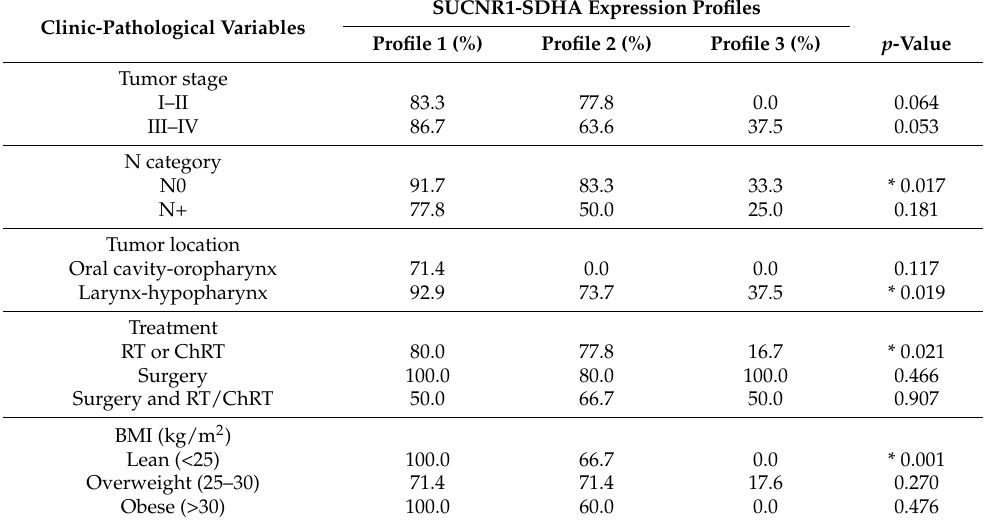
Table 4. In the univariate study, the analysis showed that the profile was significantly related to the locoregional disease-free survival. Considering patients with profile 1 as the reference category, those with higher profiles had a higher risk of local and regional failure of the tumor after treatment. Specifically, those patients included in profile 2 had a 2.5-fold higher risk of recurrence (CI 95%: 0.5–12.2, p = 0.272), and patients with profile 3 had a 6.6-fold higher risk (CI 95%: 1.4–32.1, p = 0.019). Table 3. Local and Regional Recurrence Free-Survival According to Clinical Variables and to SUCNR1 and Succinate Dehydrogenase Profiles.